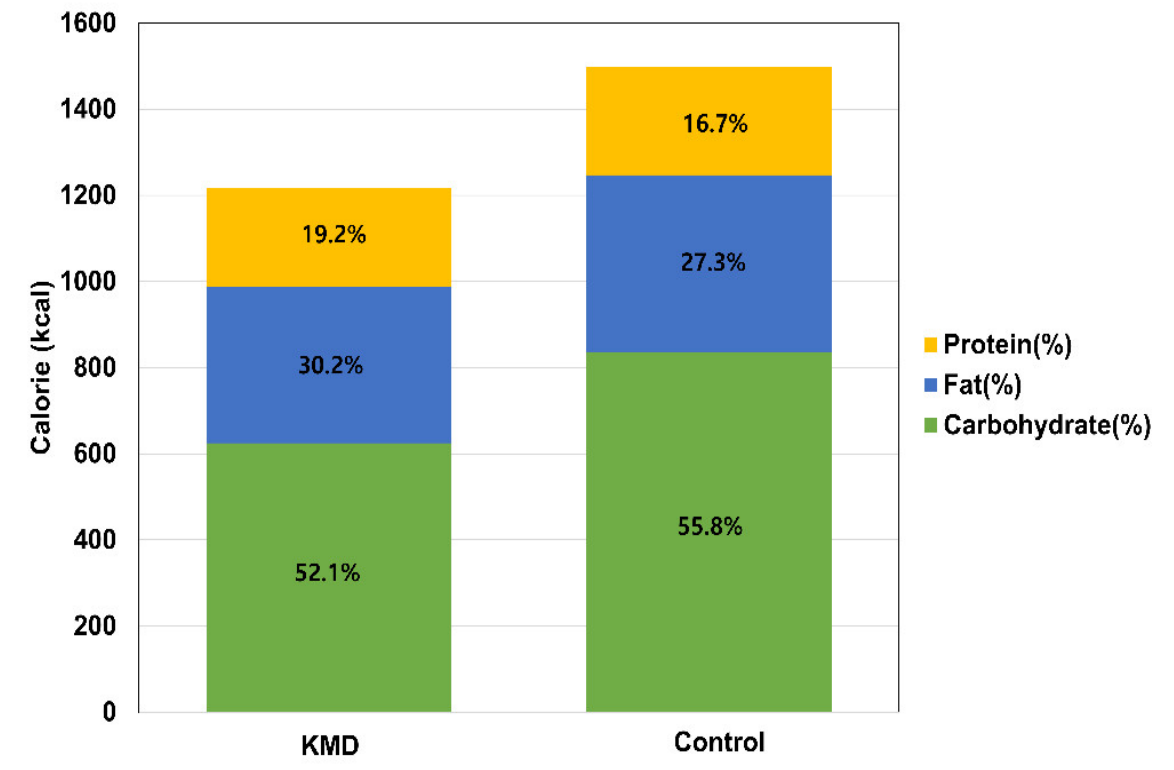
Figure 3. Macronutrient composition of each diet group.